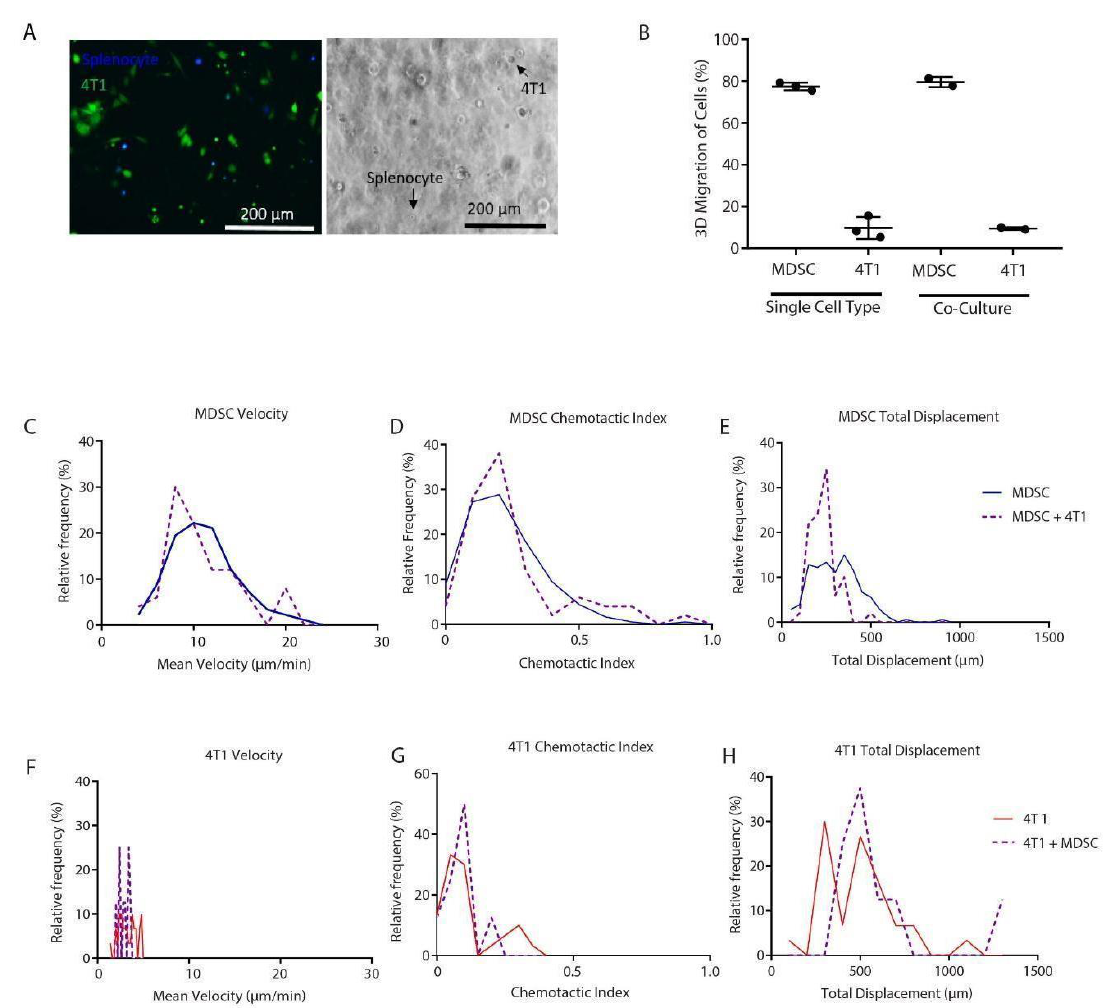
Figure 3. MDSCs migrate at higher frequency and faster than 4T1 cells in co-culture. ( A ) Representa- tive fluorescent images of sorted GR1+ MDSCs and 4T1 tumor cells in 3D co-culture (splenocytes, blue; 4T1: green) (left) and brightfield (right; black arrows indicate specific cells of interest) (scale bar: 200 µm). ( B ) Quantification of percent migration of MDSCs and 4T1 alone and in co-culture in the 3D in vitro model ( n = 3, single cell type and n = 2 for co-culture; data represent mean ±